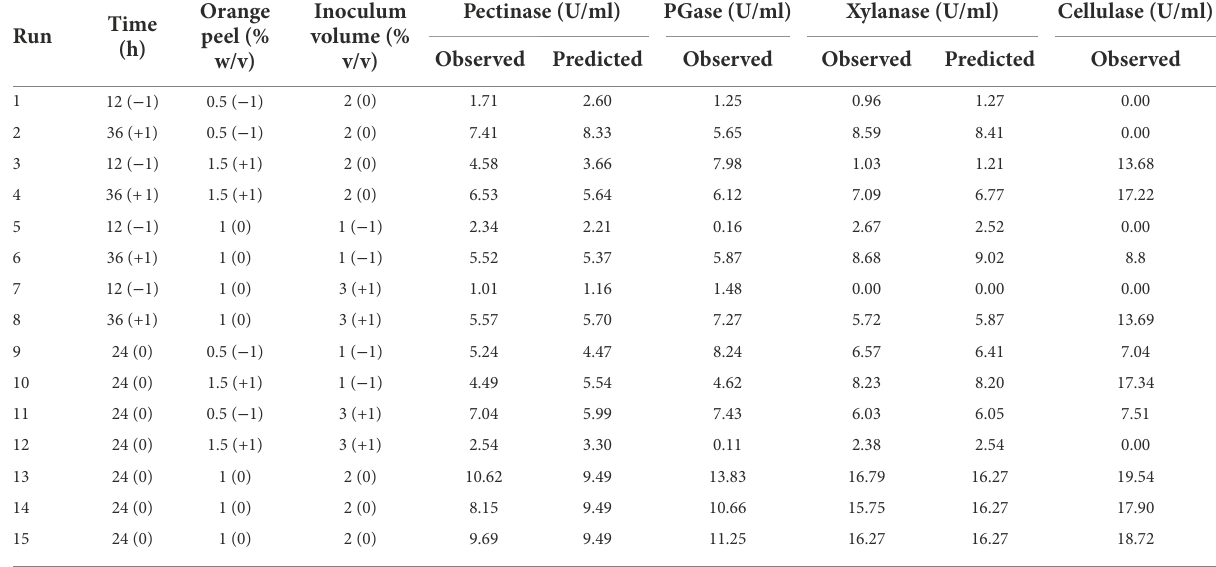
TABLE 2 Box–Behnken Design for enzymes production by using orange peel as the substrate [ − 1, 0, and +1 are the codes for the